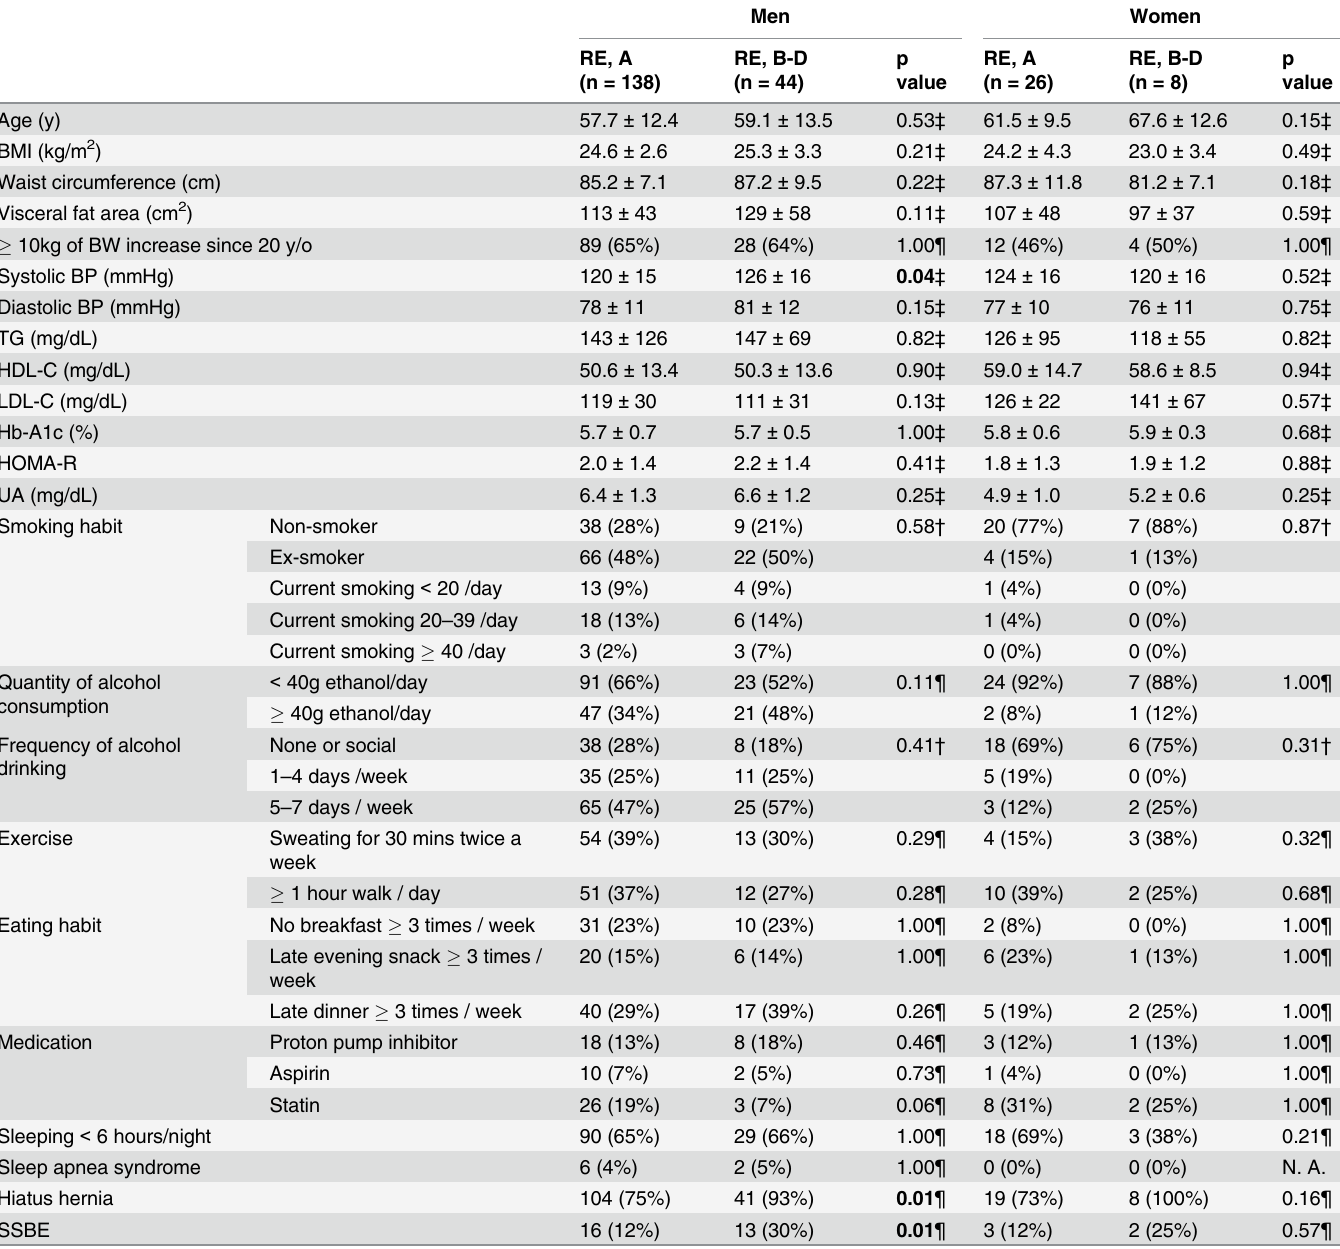
Table 2. Differences between participants with mild and severe reflux